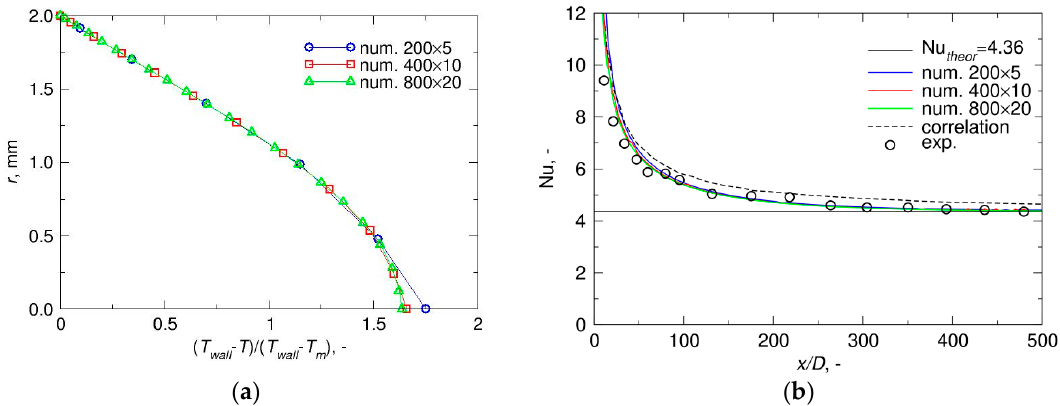
Figure 4. Results for laminar flow of water at Re = 965: ( a ) The computed dimensionless temperature profile evaluated at x / D = 625; ( b ) The computed Nusselt number.